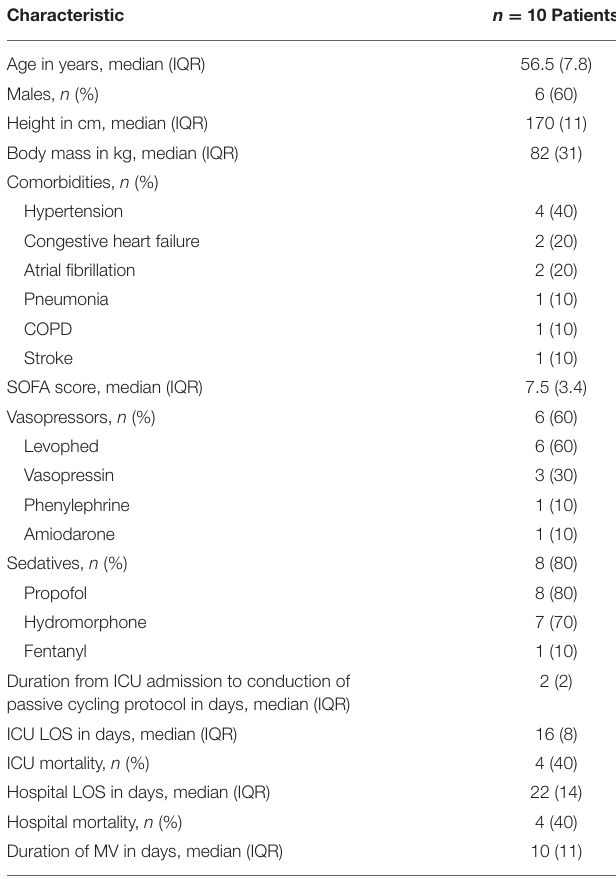
TABLE 1 | This table summarizes patient demographics and patient